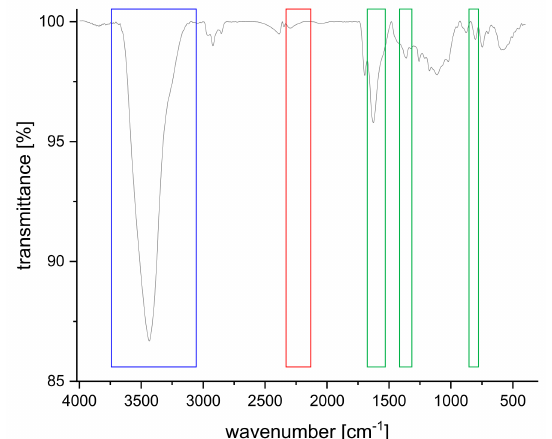
Figure 1. IR spectrum of the synthesized triazine-based framework CTF-hex6 . In green, at around 1500, 1360, and 810 cm − 1 , the IR bands for triazine units are shown; in red, at around 2200 cm − 1 , there is a small IR band for the nitrile moiety in all spectra, and between 2900 and 3600 cm − 1 , a significant signal for water (in red) is